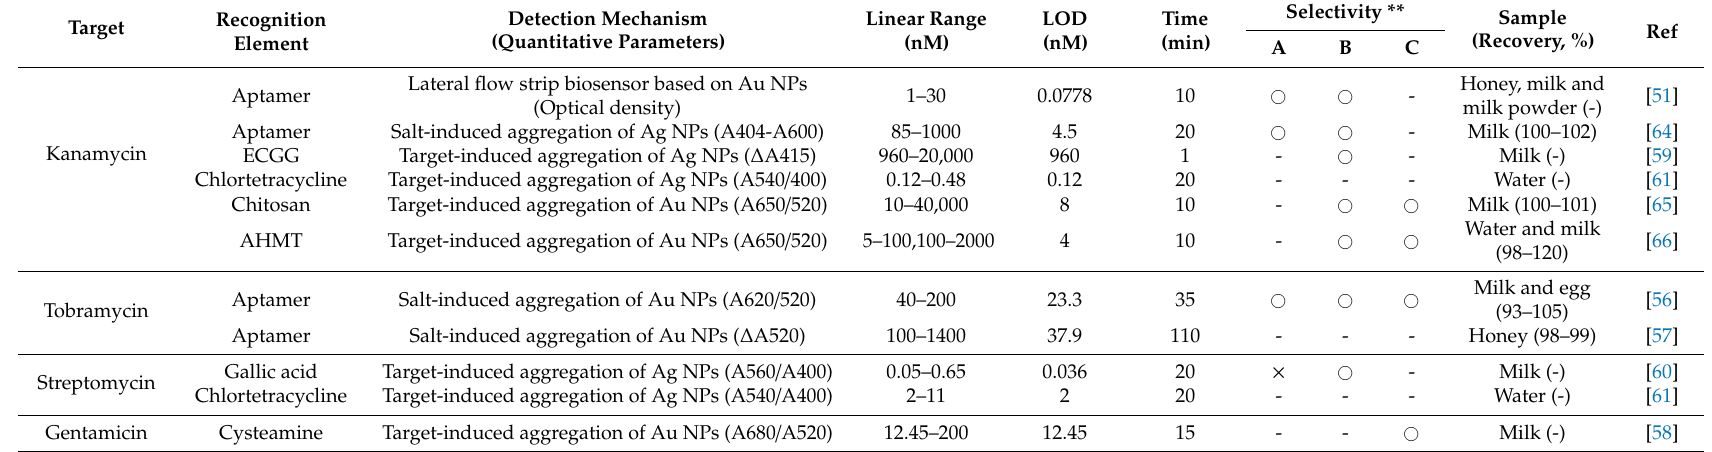
Table A2. Assay performance of typical colorimetric assays for the detection of AGs in food